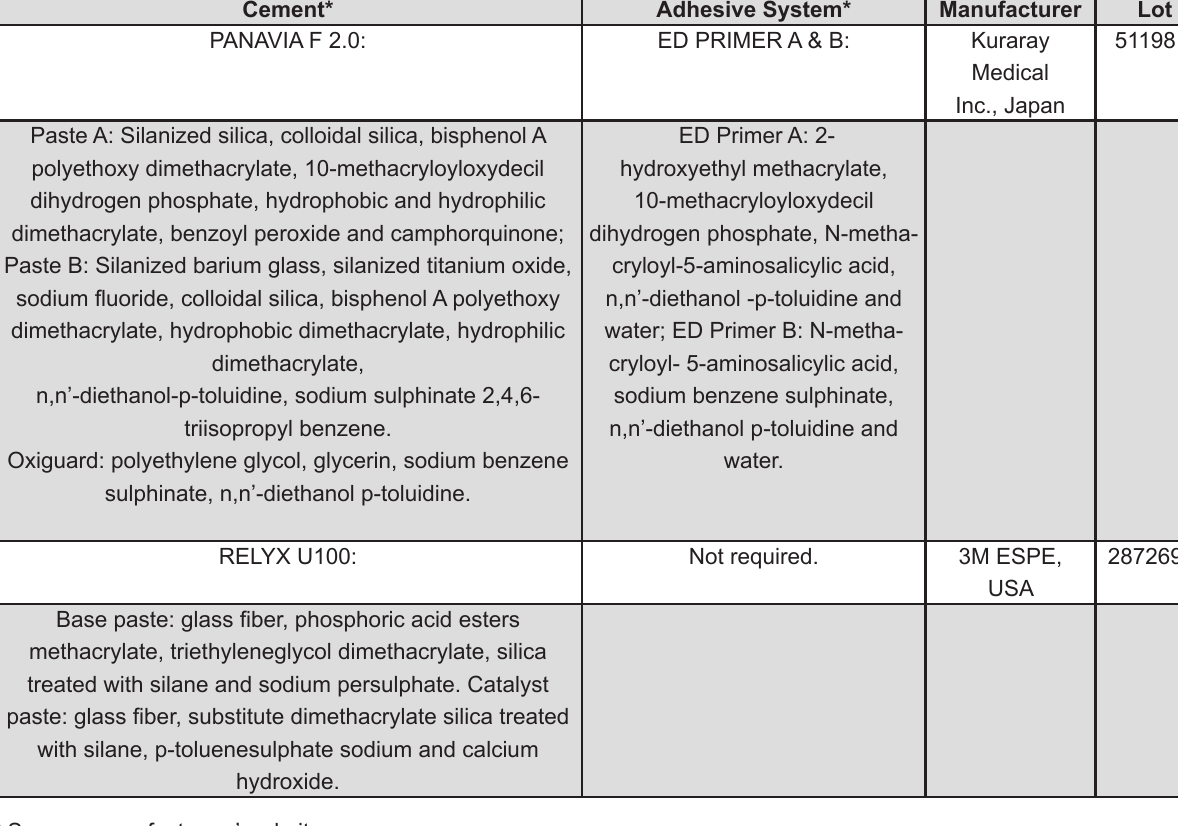
Figure 2- Resin cements used in the study